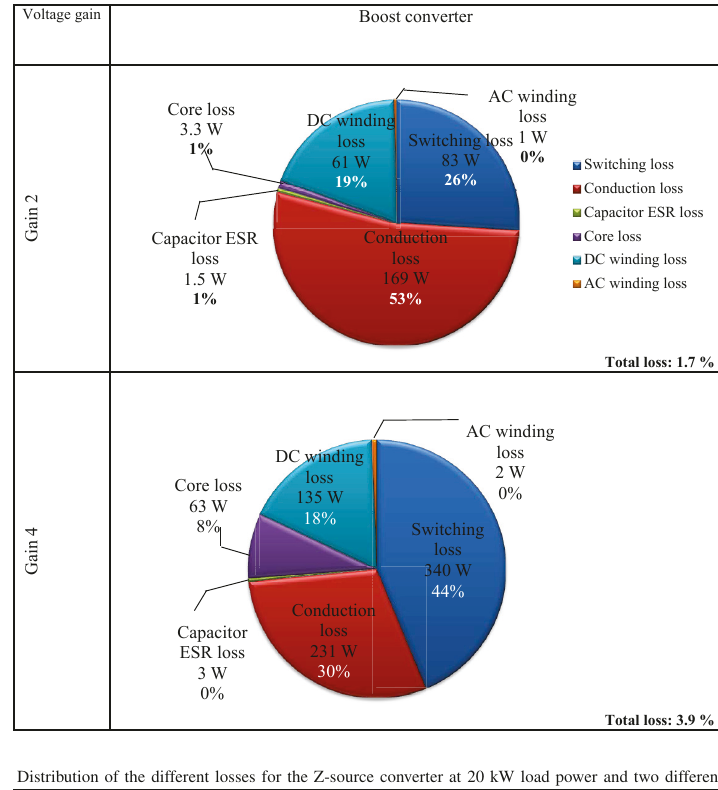
Distribution of the different losses for the Z-source converter at 20 kW load power and two different voltage gain.